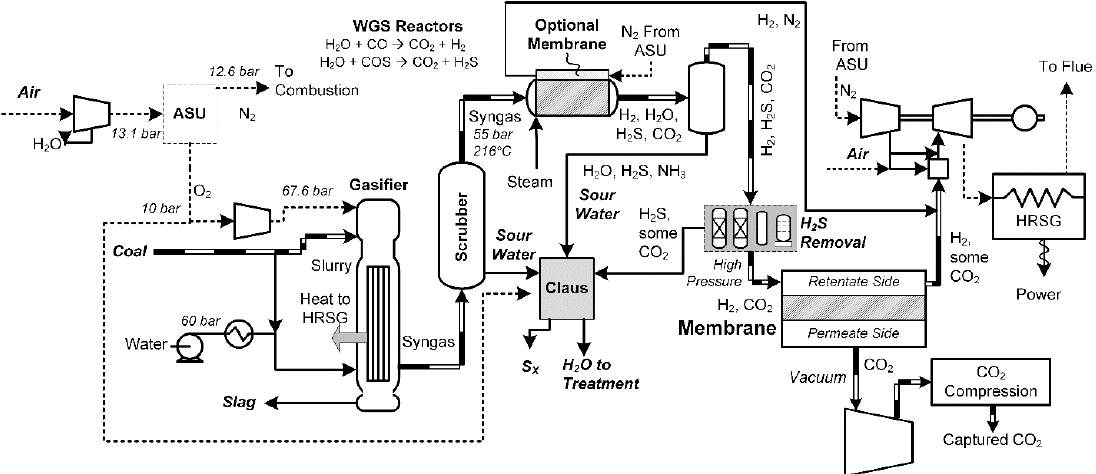
Figure 9. A superstructure of pre ‐ combustion membrane separation processes for coal.